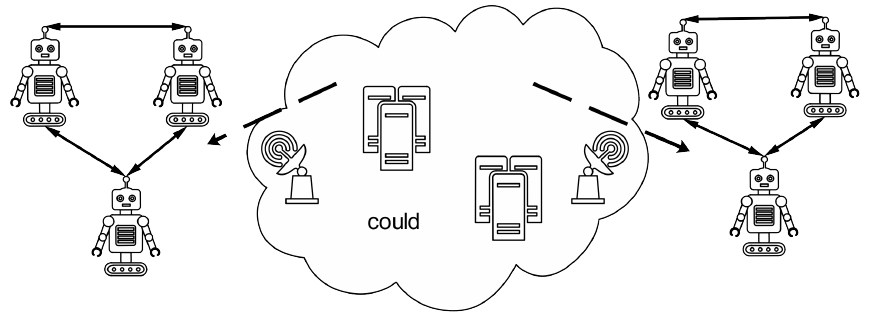
Figure 6. The architecture of cloud